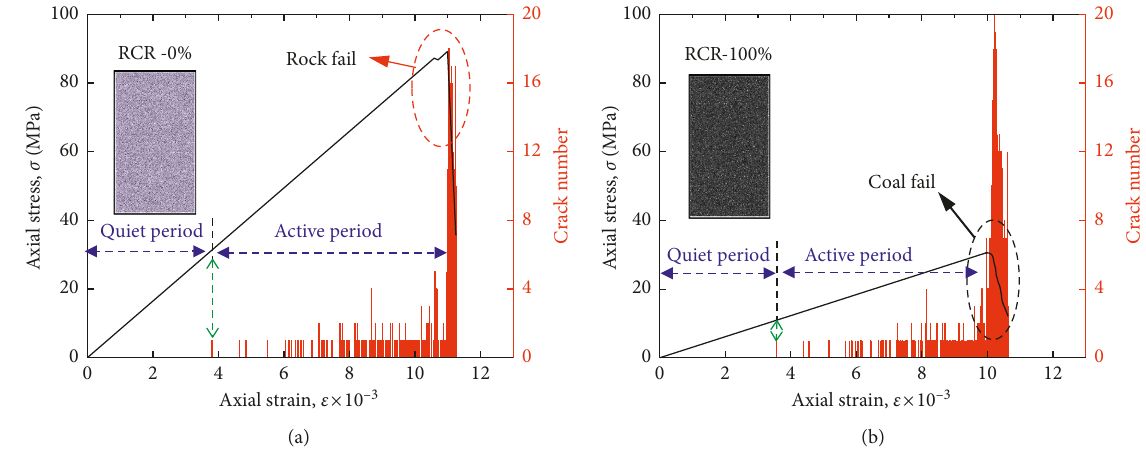
Figure 13: Microcracking evolution of pure sandstone (a) and pure coal (b) samples under uniaxial compression